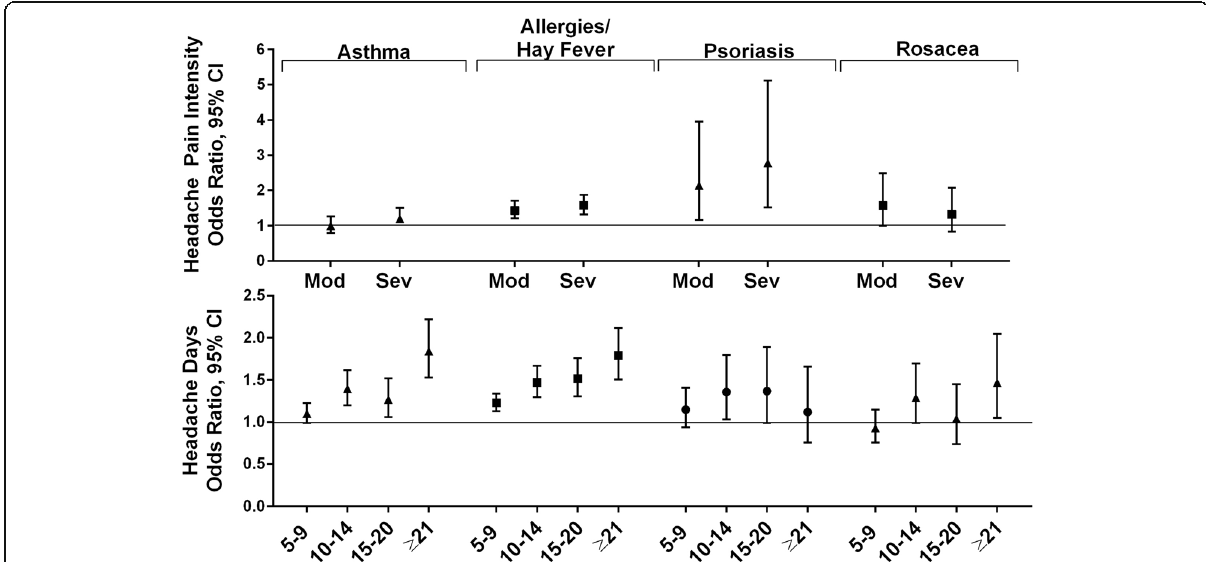
Fig. 6 Among persons with migraine the odds ratios (and 95% CI) for comorbid respiratory and dermatologic conditions*. *Fully adjusted models with sociodemographic characteristics (age, gender, Hispanic origin, race, marital status, employment, household income), headache pain